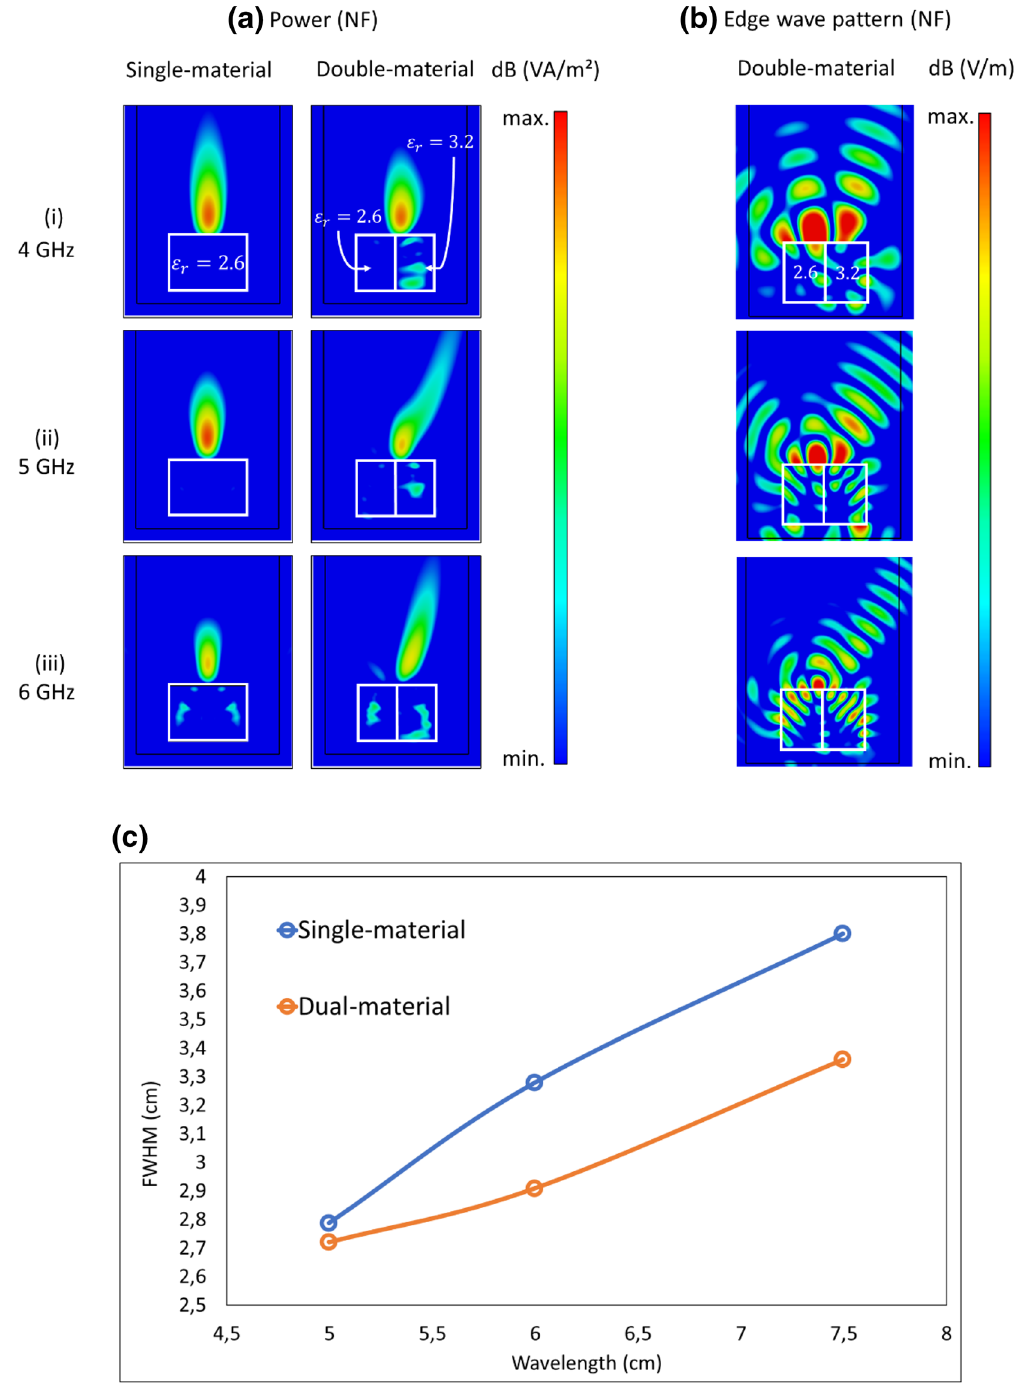
Figure 2. Numerical simulations of power ( a ) for single- and dual-material systems, and edge wave pattern ( b ) for dual-material systems at three different incident frequencies of 4 (i), 5 (ii) and 6 (iii) GHz. The incident wave illuminates the systems from the bottom. (c) FWHM of the microwave jets at different incident